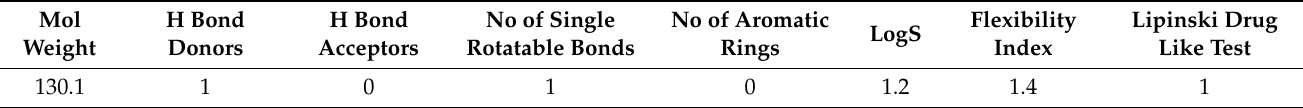
Table 2. Critical descriptors of the